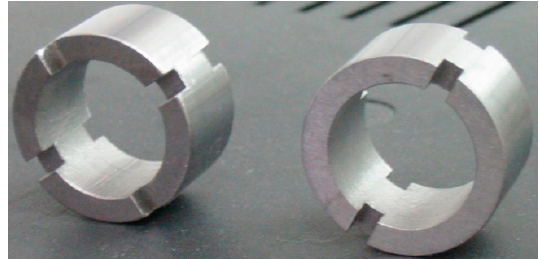
Figure 7. View of associated pairs.